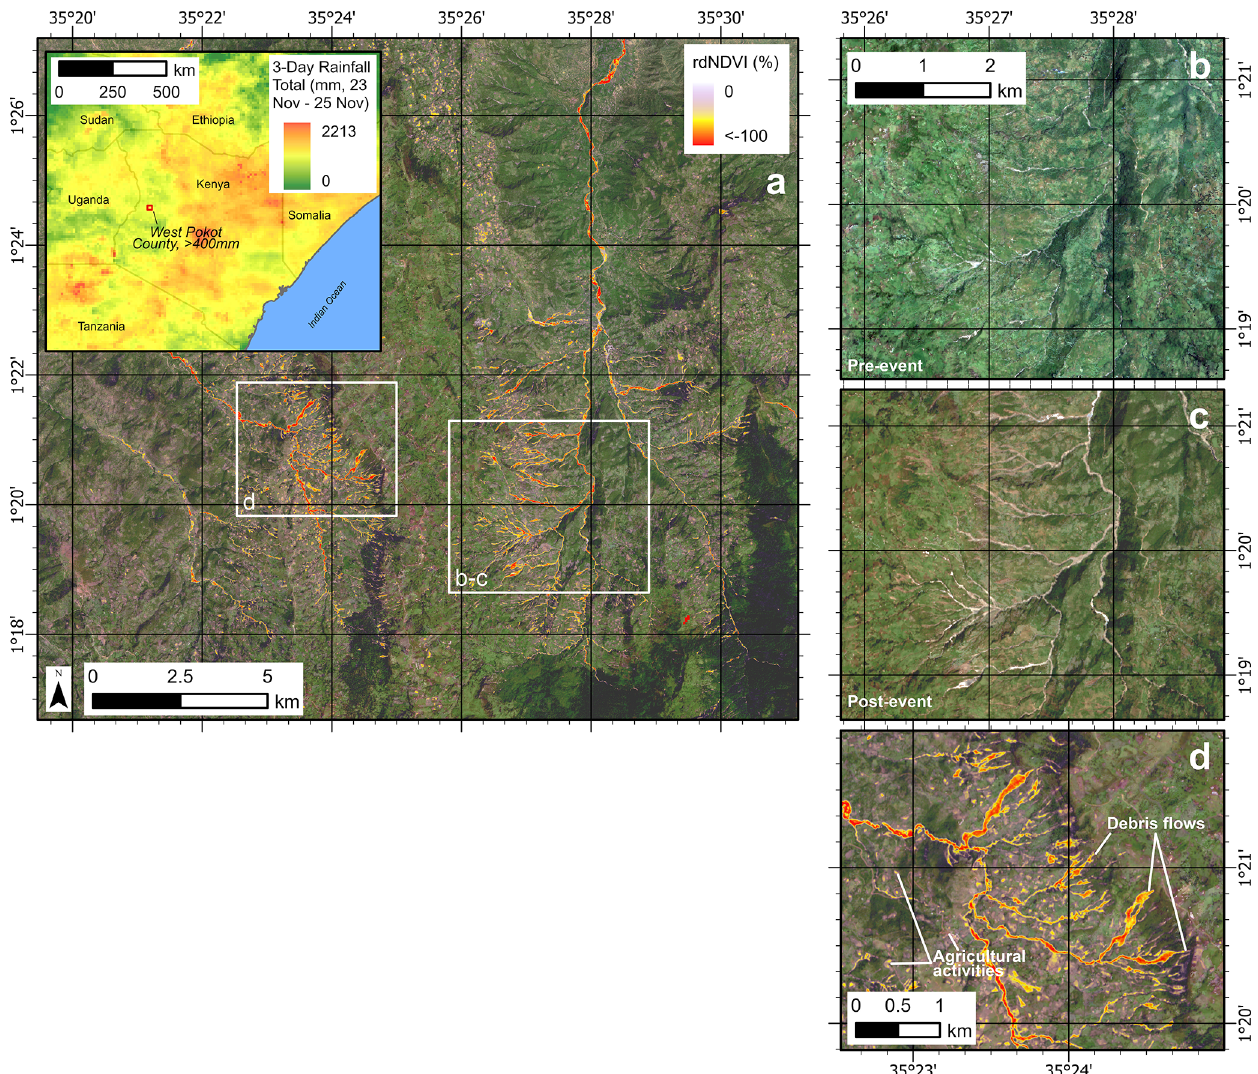
Figure 3. rdNDVI change detection images and greenest-pixel composites following the 23 November 2019 rainfall-induced mass-wasting event in West Pokot County, Kenya. See inset map for location and 3d rainfall totals from storm, courtesy of NASA Integrated Multi- satellitE Retrievals for GPM (IMERG) program. Parameters – dataset: Sentinel-2; event date: 23 November 2019; pre-window: 2 months; post-window: 0.5 months; maximum cloud cover: 30%; slope threshold: 0 ◦ . West Pokot County received > 400mm of rain in the 72h period 23–25 November, triggering landslides, debris flows, and floods during the heaviest rainfall on 23 November. (a) rdNDVI illustrates hillslope and low-order stream channel disturbance, leading to debris flows on the upper slopes and vegetation loss and sedimentation along river channels flowing toward the north and northwest. Landscape change is easier to interpret with rdNDVI compared to observations based only on pre- and post-event color images ( b and c ). Base image is post-event. (b) Pre-event greenest-pixel composite image showing relatively green vegetative cover across landscape. (c) 0.5-month post-event greenest-pixel composite illustrates reduction in vegetation in landslide and debris flow tracks and along-river trunk channel. This reduction in vegetation is noted by negative rdNDVI values as seen in (a) . (d) Close-up detail of negative rdNDVI values associated with mass wasting. Rectilinear patches of negative rdNDVI values in western area of (d) illustrate agricultural clearing or harvest activities across the event parameters. In mass-wasting applications, further use of slope thresholding and interpretation based on landscape morphology will reduce these undesired rdNDVI artifacts. User interpretation of output rdNDVI polygon areas is always warranted in order to minimize unwanted artifacts. Panels (b) and (c) have the same map scale. Panels (a) and (d) have the same rdNDVI color scale. rdNDVI and greenest-pixel composite data exported from HazMapper, available